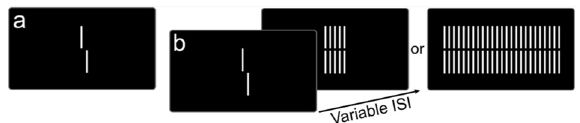
Fig. 1 Stimuli. a Vernier stimuli consisting of two vertical bars offset to the right (or left not presented). b Visual backward masking with the grating consisting of either 5 or 25